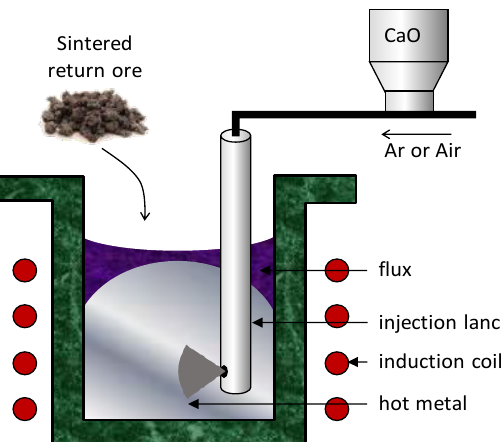
Figure 2. Schematic illustration of experimental apparatus with CaO injection.